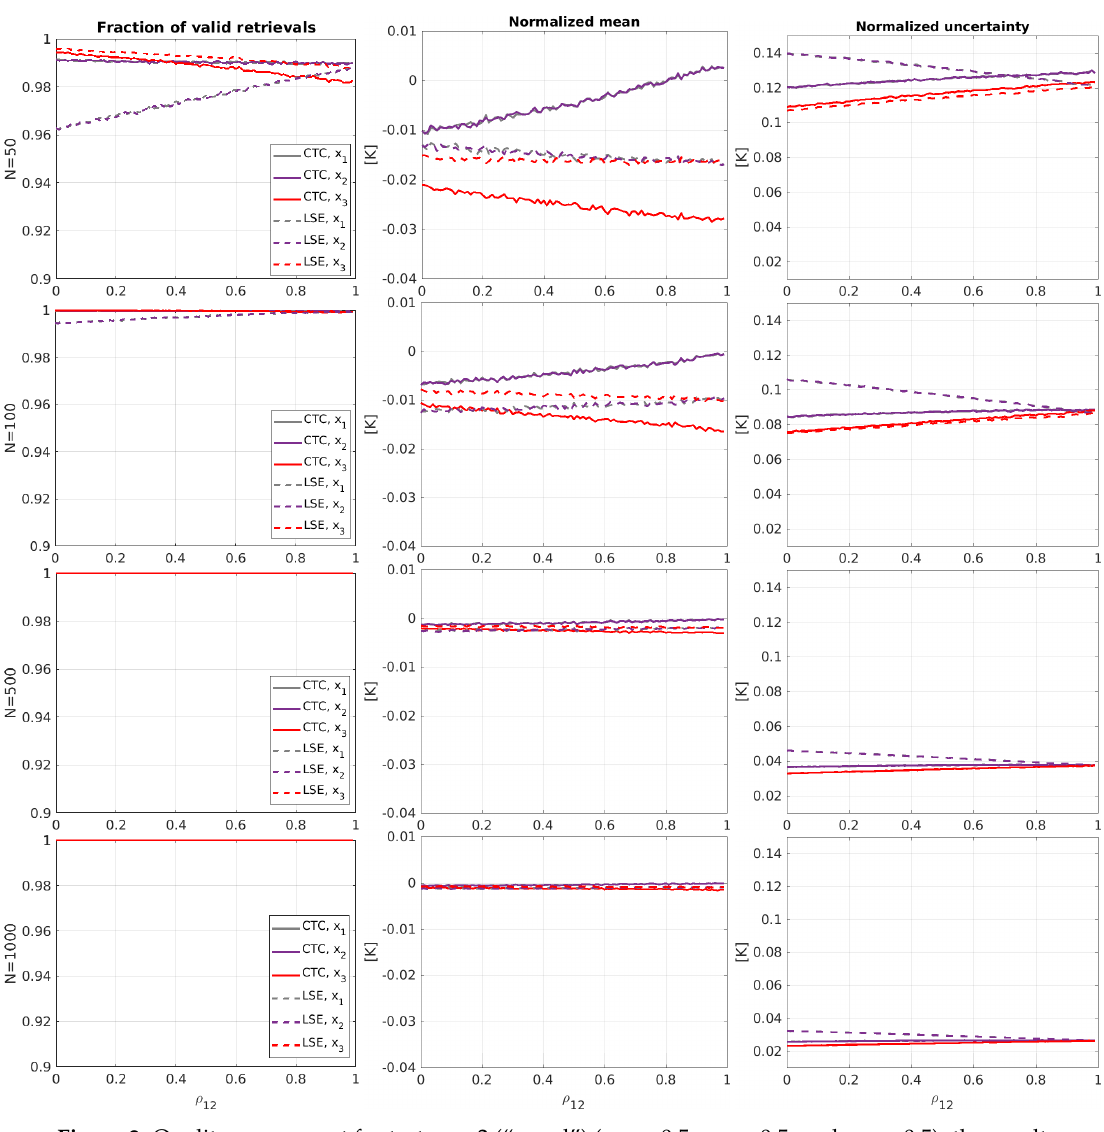
Figure 2. Quality assessment for test case 2 (“equal”) ( σ δ are shown as a function of the correlation parameter ρ 12 . From left to right: Fraction of valid retrievals, normalized mean, and normalized uncertainty. From top to bottom: Results for N = 50, N = 100, N = 500, and N = 1000. Grey color corresponds to the measurement x 1 , purple is for measurement x 2 , and red is for measurement x 3 . Solid lines are the results for correlated triple collocation, while dashed lines are for least squared error triple